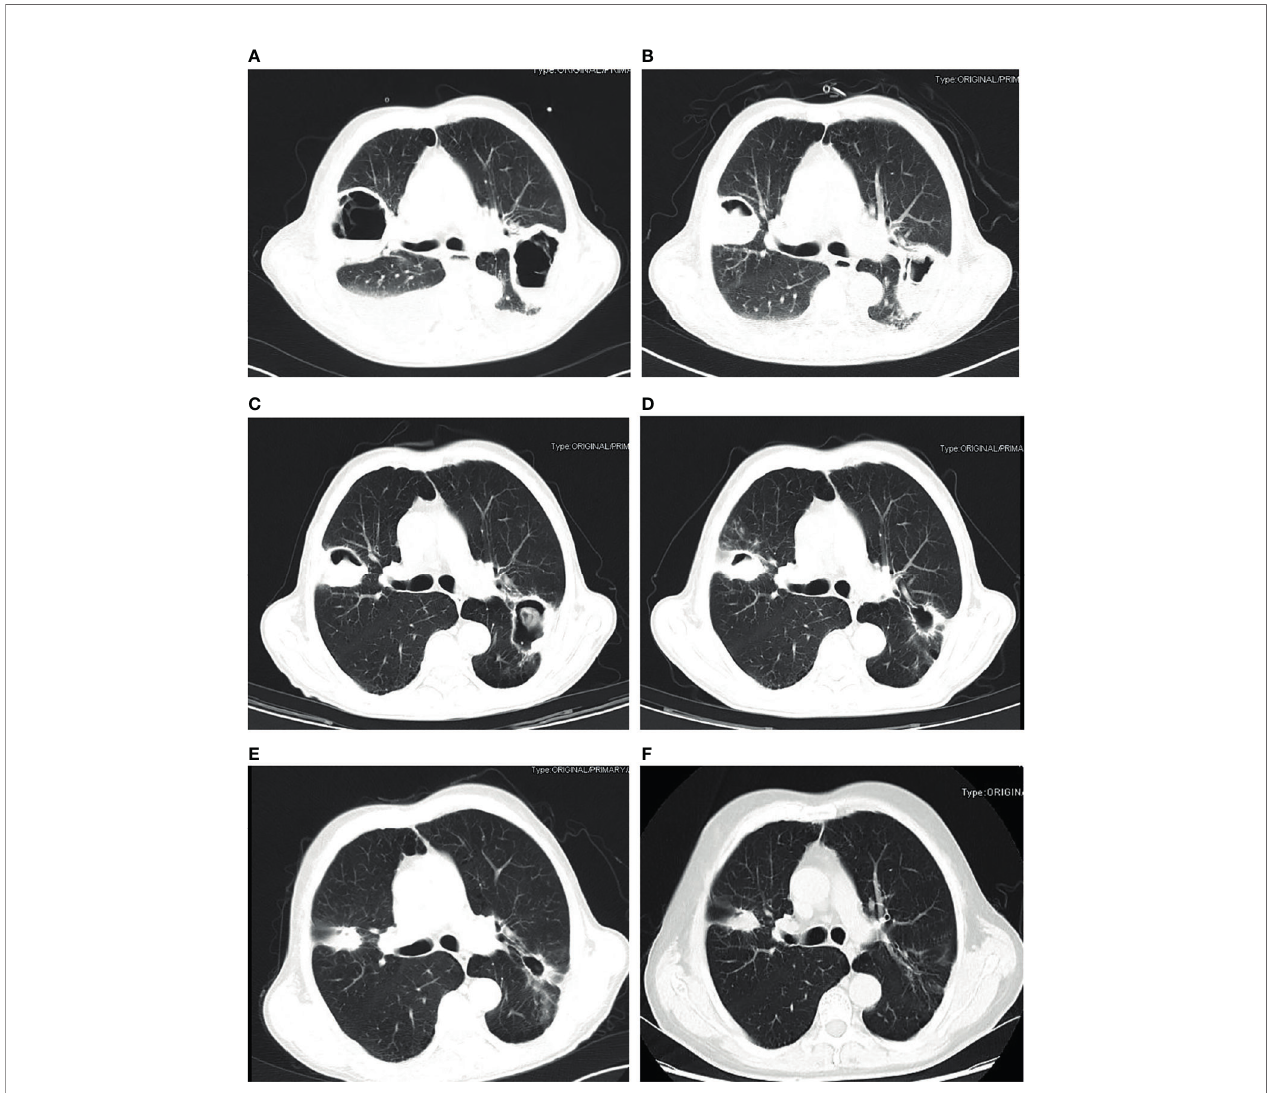
FIGURE 2 | Pulmonary fungal infection ( Mucor with Aspergillus ) ina 69-year-old man with uncontrolleddiabetes, chronic obstructive pulmonary disease and liver cirrhosis. CT imagingshowed thick-walledcavity shadow with gas- fl uid level inthe right upper lobeand leftlower lobeof the lung (A) . The lesion was signi fi cantly reduced after halfa month of treatment with posaconazole (B) . The lesion continued to shrink after 40 days (C) , three months (D) , fi vemonths (E) and1 year (F) of